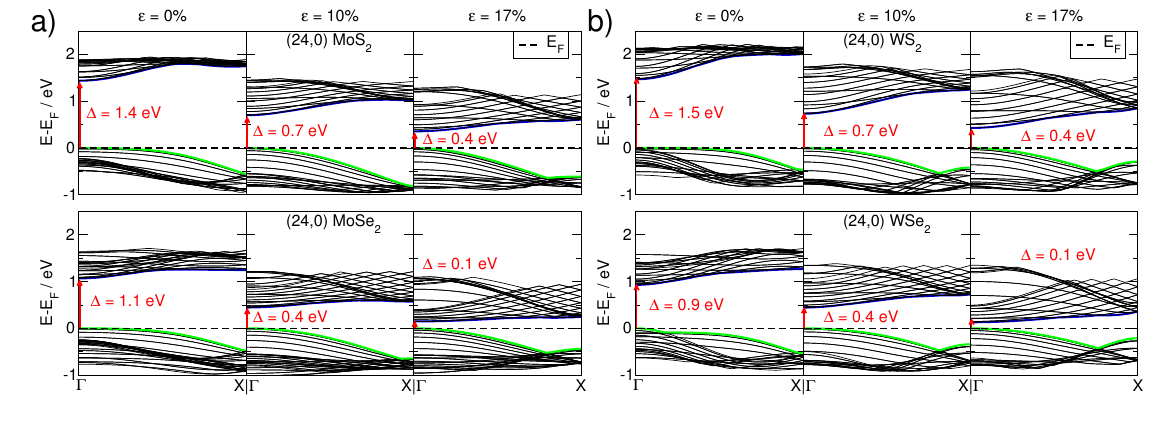
Figure 4. The calculated band structure response to the applied tensile strain of zigzag TX NTs. ( a ) MoX and ( b ) WX 2 2